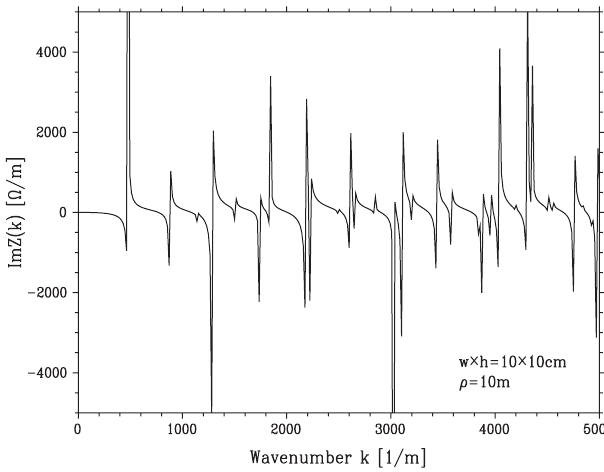
FIG. 2. CSR impedance of a square pipe. The pipe width and the height are w (cid:11) h ¼ 10 cm (cid:11) 10 cm , the bending radius is ¼ 1 in Eq. (cid:3) ¼ 10 m . We put (cid:5) ¼ 1 and (cid:3) p